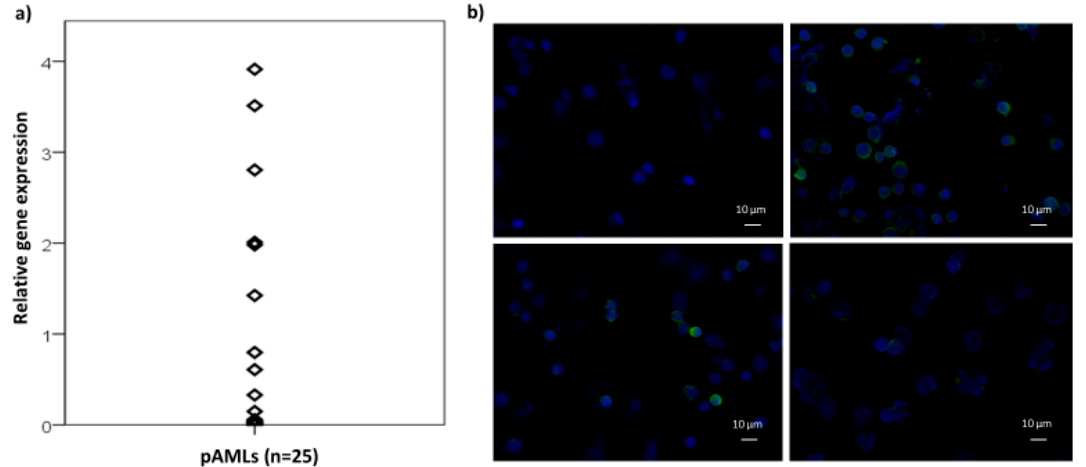
Figure 1. Expression of PLS3 in primary AML samples. ( a ) The mRNA expression of primary AML samples was analyzed by RT-qPCR and normalized to GAPDH. The relative expression is shown in comparison to Kasumi-1 cells (expression value of 1). ( b ) PLS3 protein expression in primary AML samples was analyzed by immunofluorescence (green signals). The panel upper left shows the negative control without primary antibody while the lower left and right panels show the PLS3 staining of three primary AML samples of varying PLS3 expression intensity, respectively.